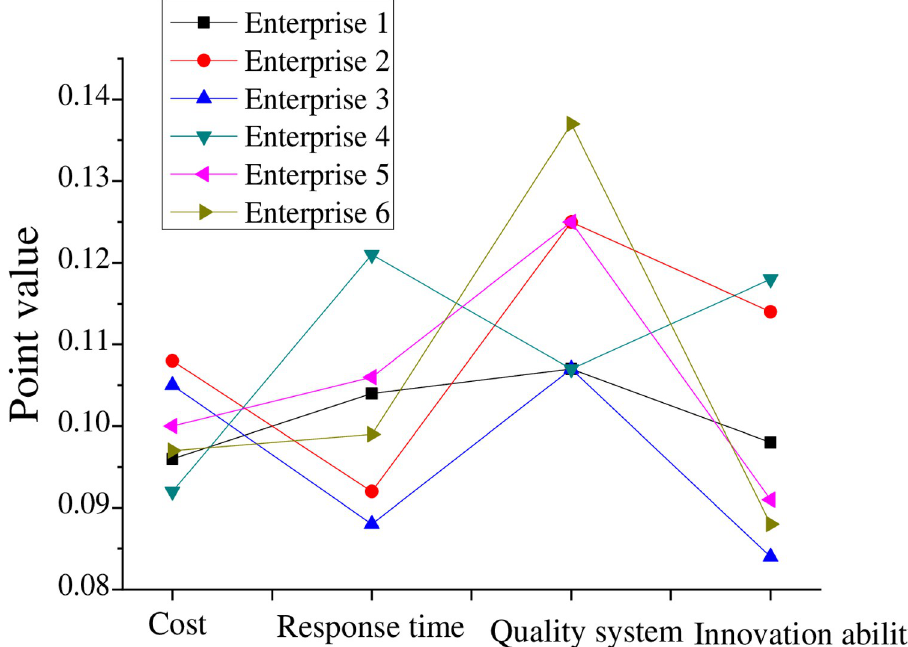
Fig 5. Comparison of point values of technical candidate enterprises after the